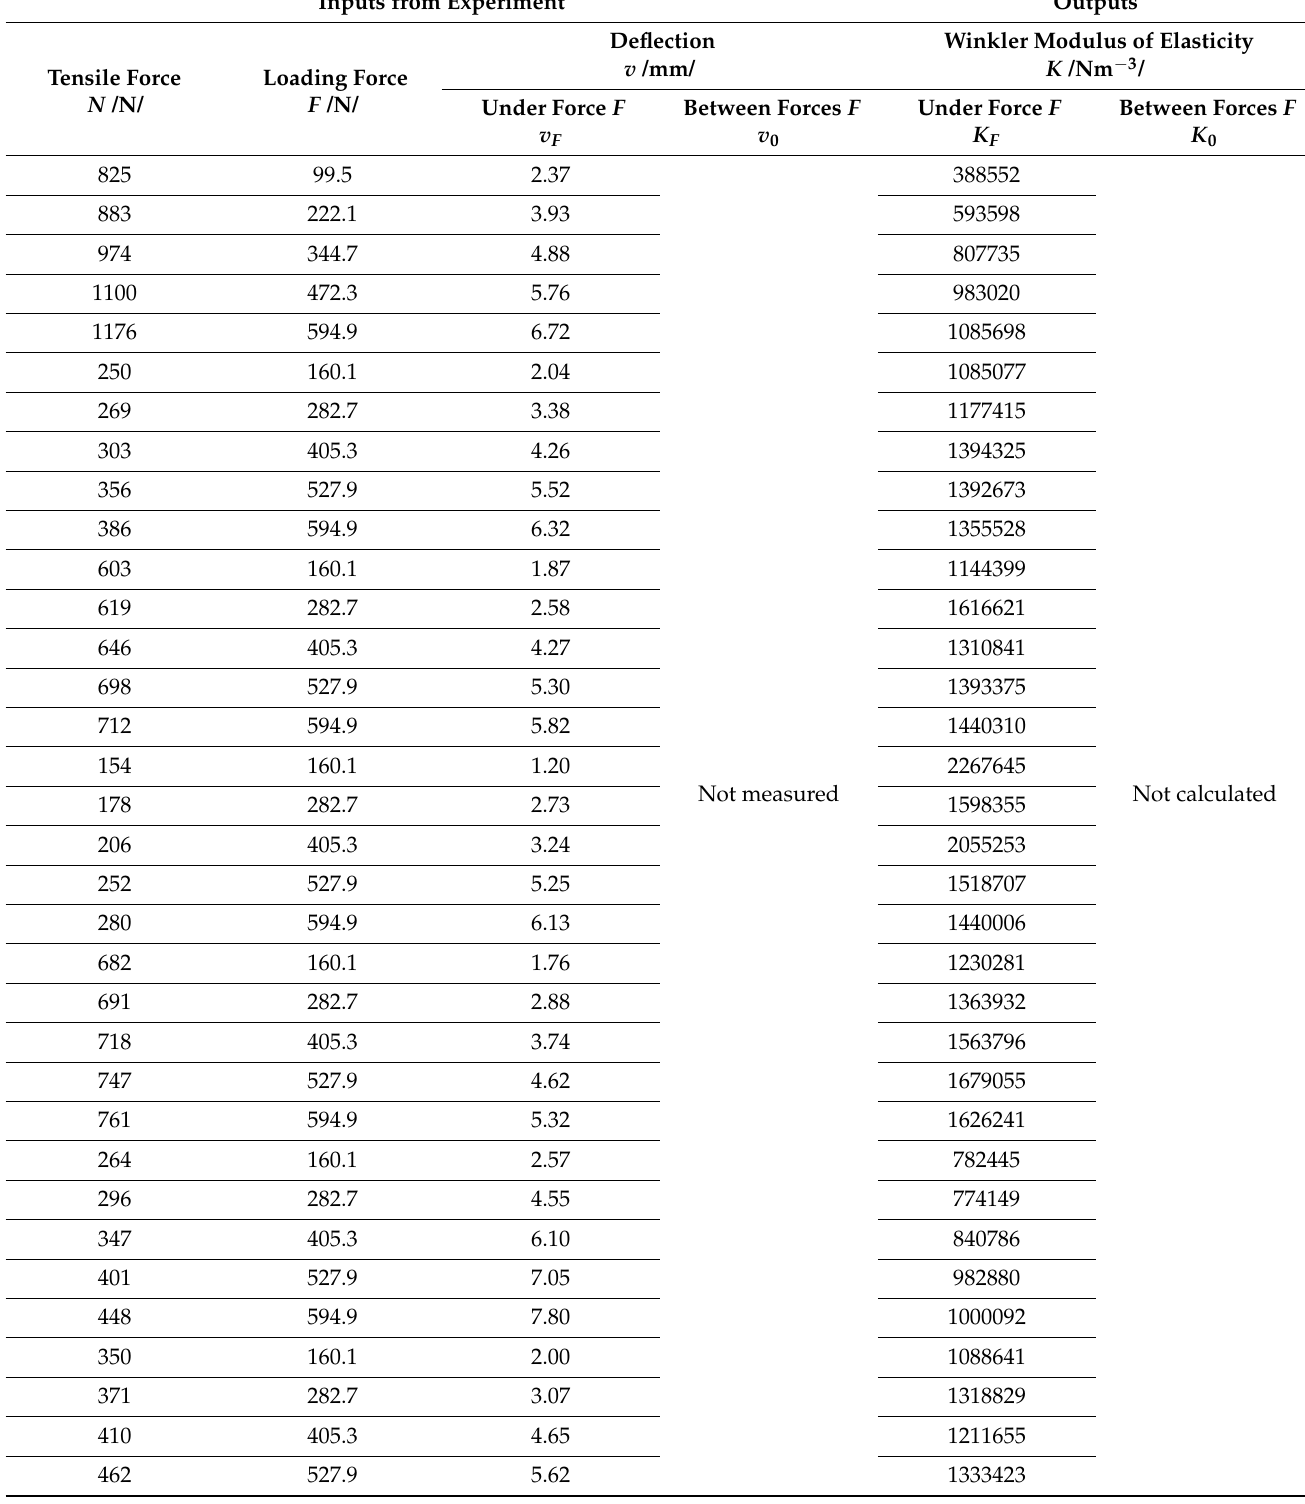
Table 4. Winkler moduli of foundation K /Nm − 3 / for individual measurements for the thickness of the wheat layer h = 72 mm according to Figure